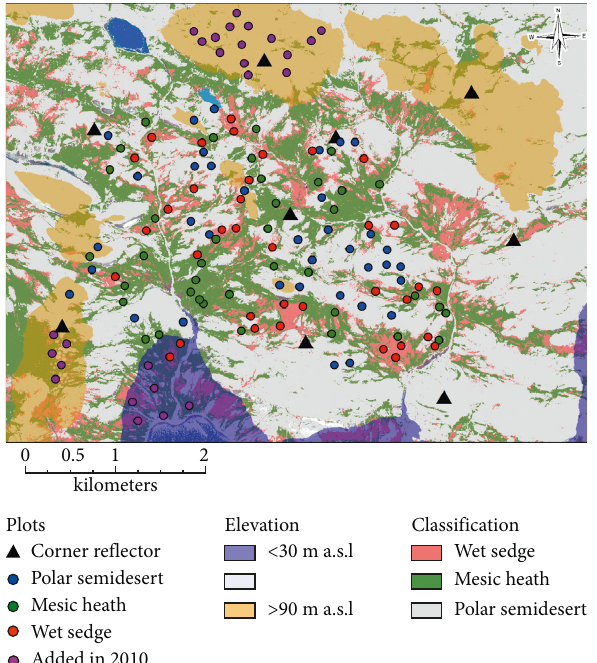
Figure 2: Unsupervised classification, elevation stratification, and plot locations at the Cape Bounty Arctic Watershed Observatory.